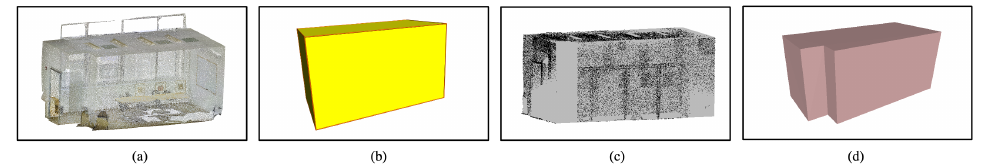
Figure 13. Reconstructed results generated from the proposed method and state-of-art ones. ( a ) raw input point clouds, ( b ) mesh surface generated from Polyfit [30], ( c ) the restricted results and inliers points generated from [51], ( d ) mesh surface generated from TC-SM method.